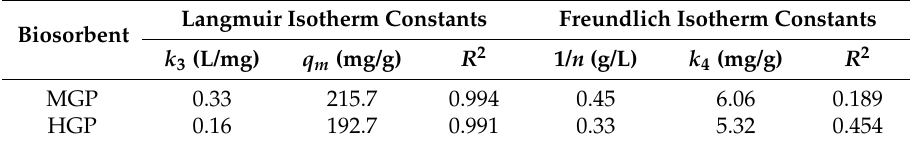
Table 2. Constants of Langmuir and Freundlich simulations of MB adsorption isotherms. Langmuir Isotherm Constants Freundlich Isotherm Constants Biosorbent